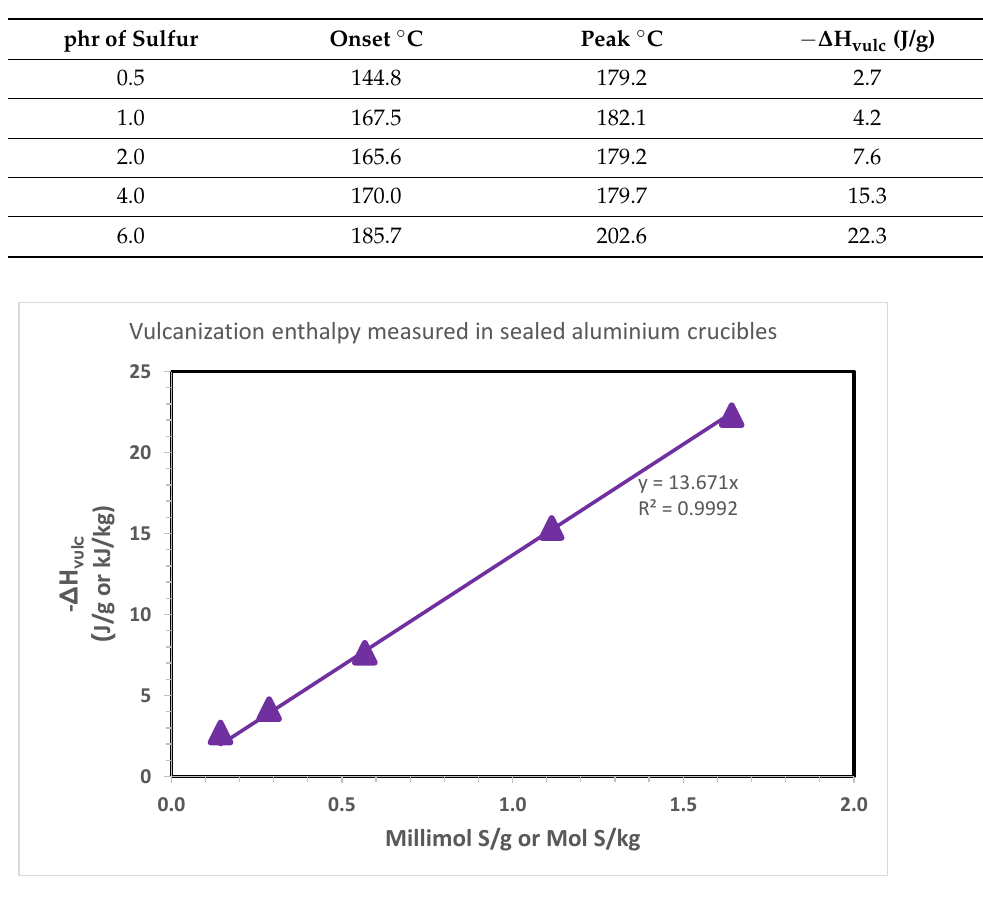
Figure 3. Vulcanization enthalpy measured with DSC on the compounds of Table 1. Heating rate 10 °C/min in sealed Al crucibles from room temperature to 350 °C. The vulcanization thermal param- eters are shown in Table 2.